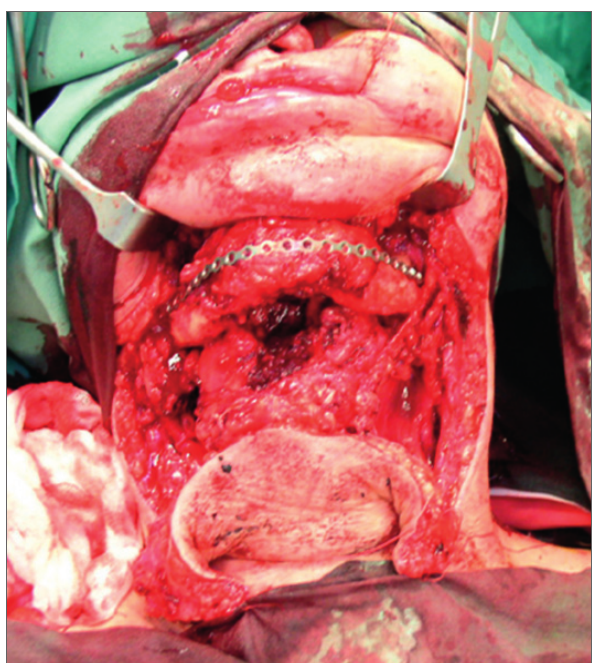
Fig. 2. Free fibula after fixation in defect. Fig. 3. Frontal image of skull after reconstructive surgery.